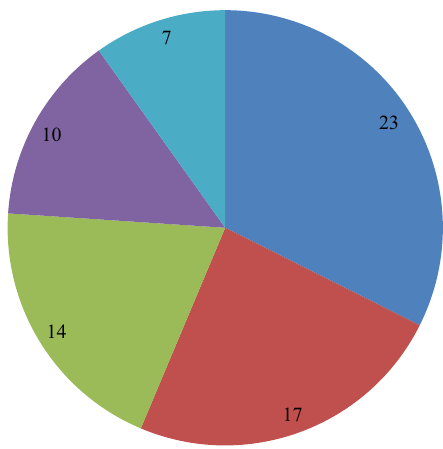
Figure 5: Mode of utilization of medicinal